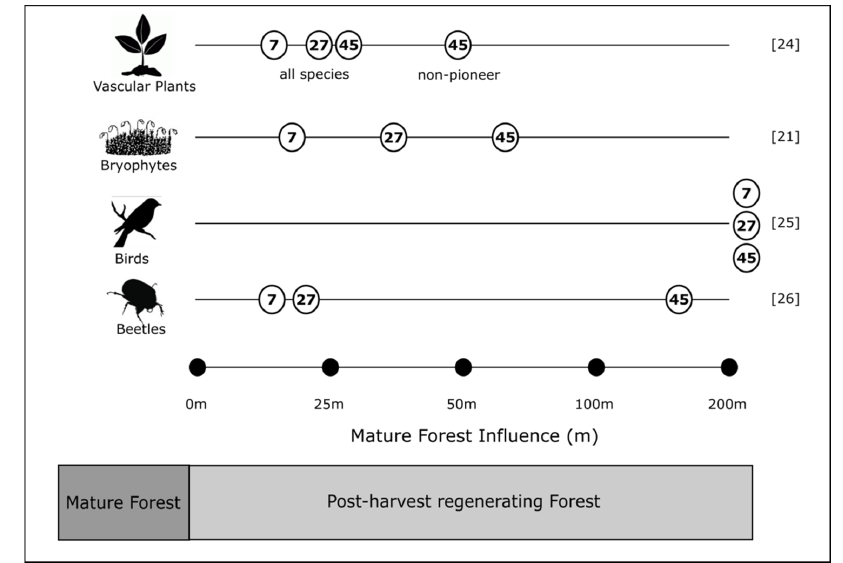
Figure 1. Mature Forest Influence for a suite of mature-forest-associated species in the wet eucalypt forests of Tasmania based on a series of concurrent studies in Southern Forests Tasmania [21,24–26].